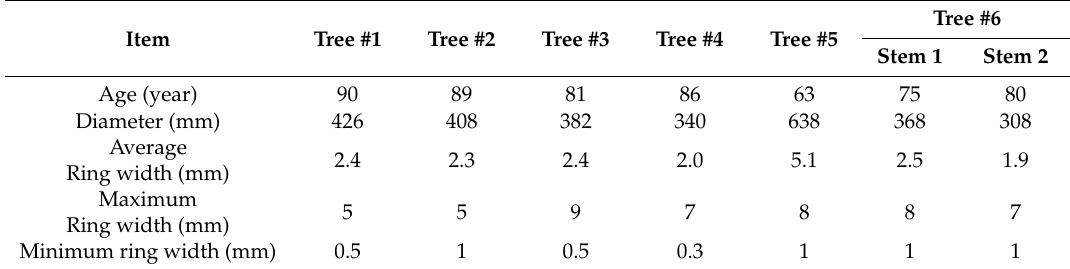
Table 1. Tree ring information of six Chinese Torreya